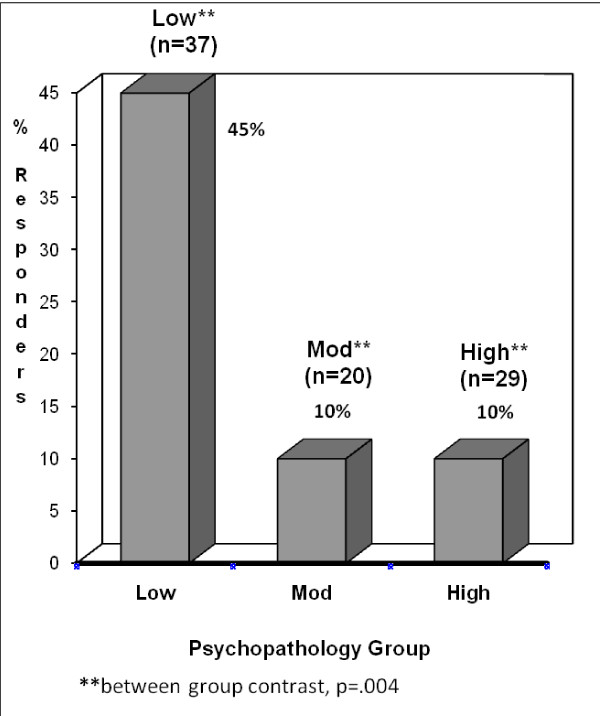
Percentage of Patients in Each Group with 30% Improvement. **between group contrast, p = .004